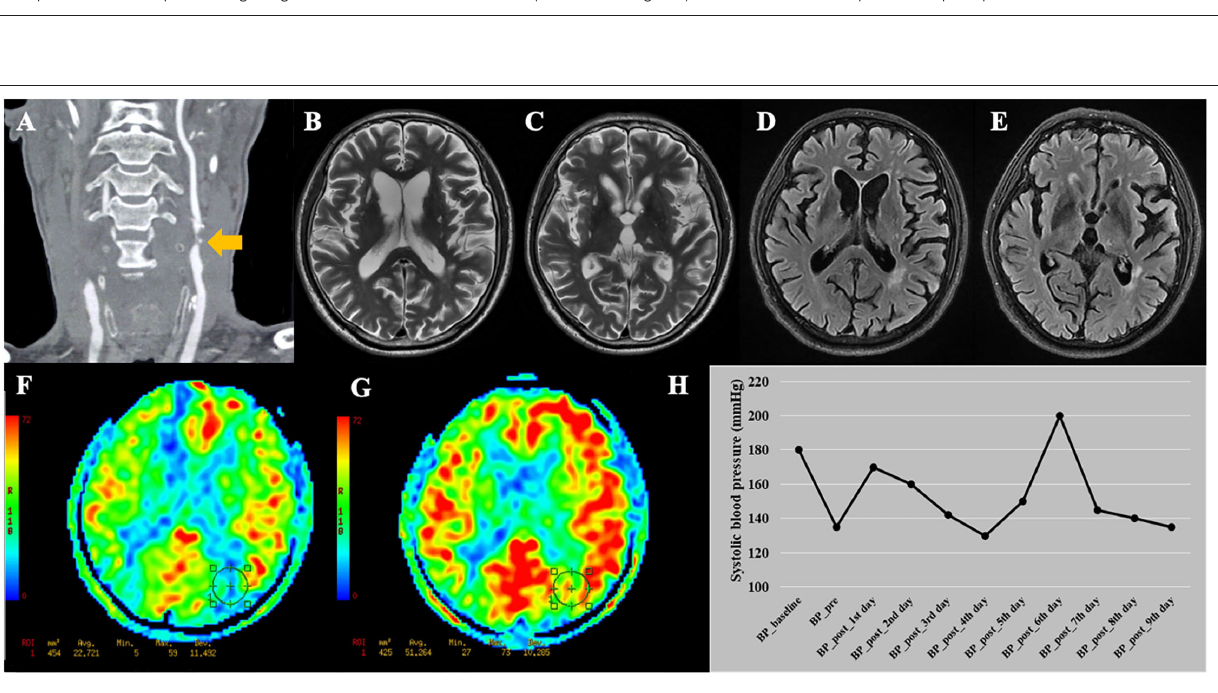
FIGURE 4 | A representative case of cerebral hyperperfusion syndrome. (A) This patient was diagnosed with bilateral severe carotid stenosis. During this hospitalization, this patient received carotid endarterectomy (CEA) on the left side. (B–E) Pre-operative T2WI and FLAIR show Fazekas score of 4 points and multiple lacunes in bilateral basal ganglia and left thalamus. (F) Pre-operative arterial spin labeling image shows a significantly decreased cerebral blood flow (22.72 ml/100 g/min) in the watershed area. (G) Post-operative arterial spin labeling image shows the cerebral blood flow (51.26 ml/100 g/min) increase > 100% compared with pre-operative values. (H) This patient developed cerebral hyperperfusion syndrome during the first day after CEA with systolic blood pressure of 170 mmHg. The patient experienced dysphoria, delirium under fluctuating blood pressure. After adjusting the medication, the patient discharged with stable blood